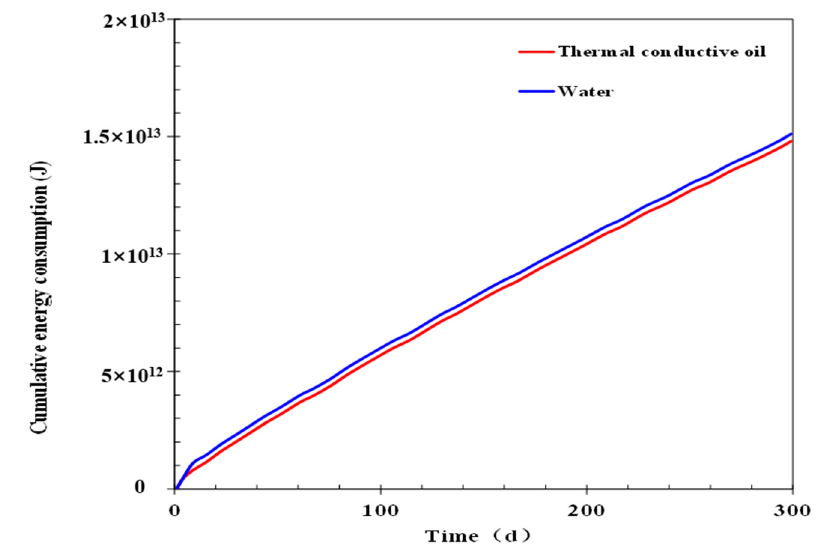
Figure 12. The energy consumption at different temperatures.